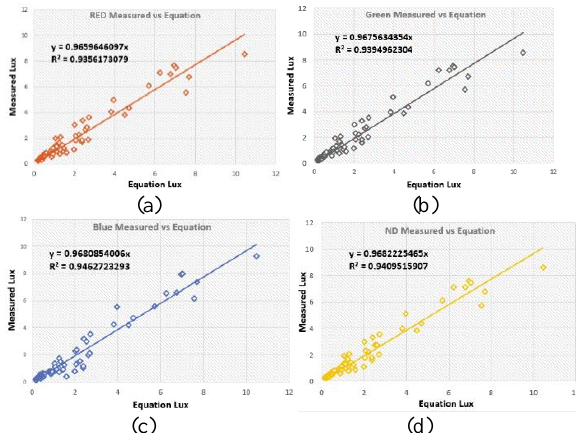
Figure 7. Scattered plot of computed illuminance vs. measured illuminance using regression model of (a) red (b) green (c) blue (d) ND.